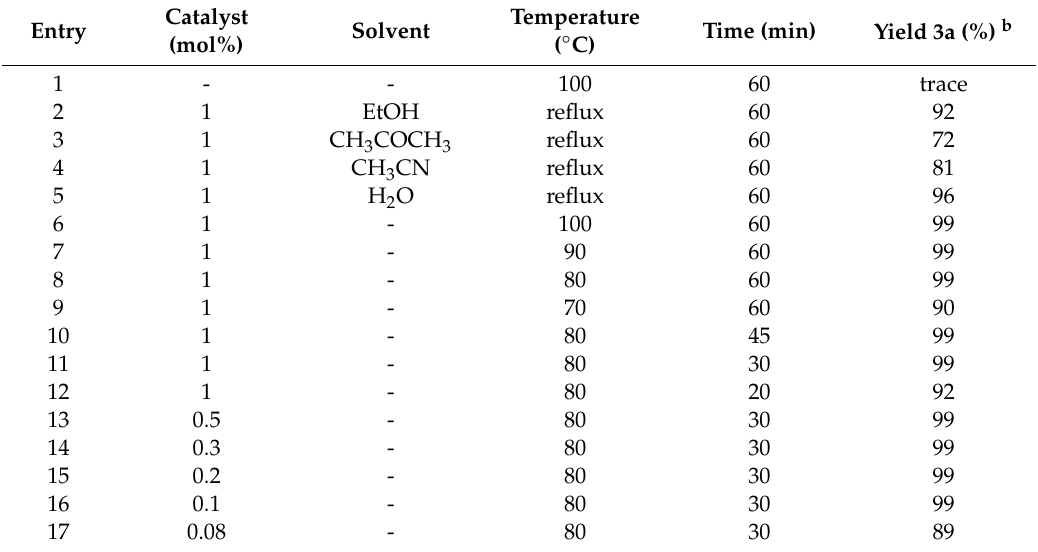
Table 1. Optimization of synthetic conditions for the synthesis of xanthenes a